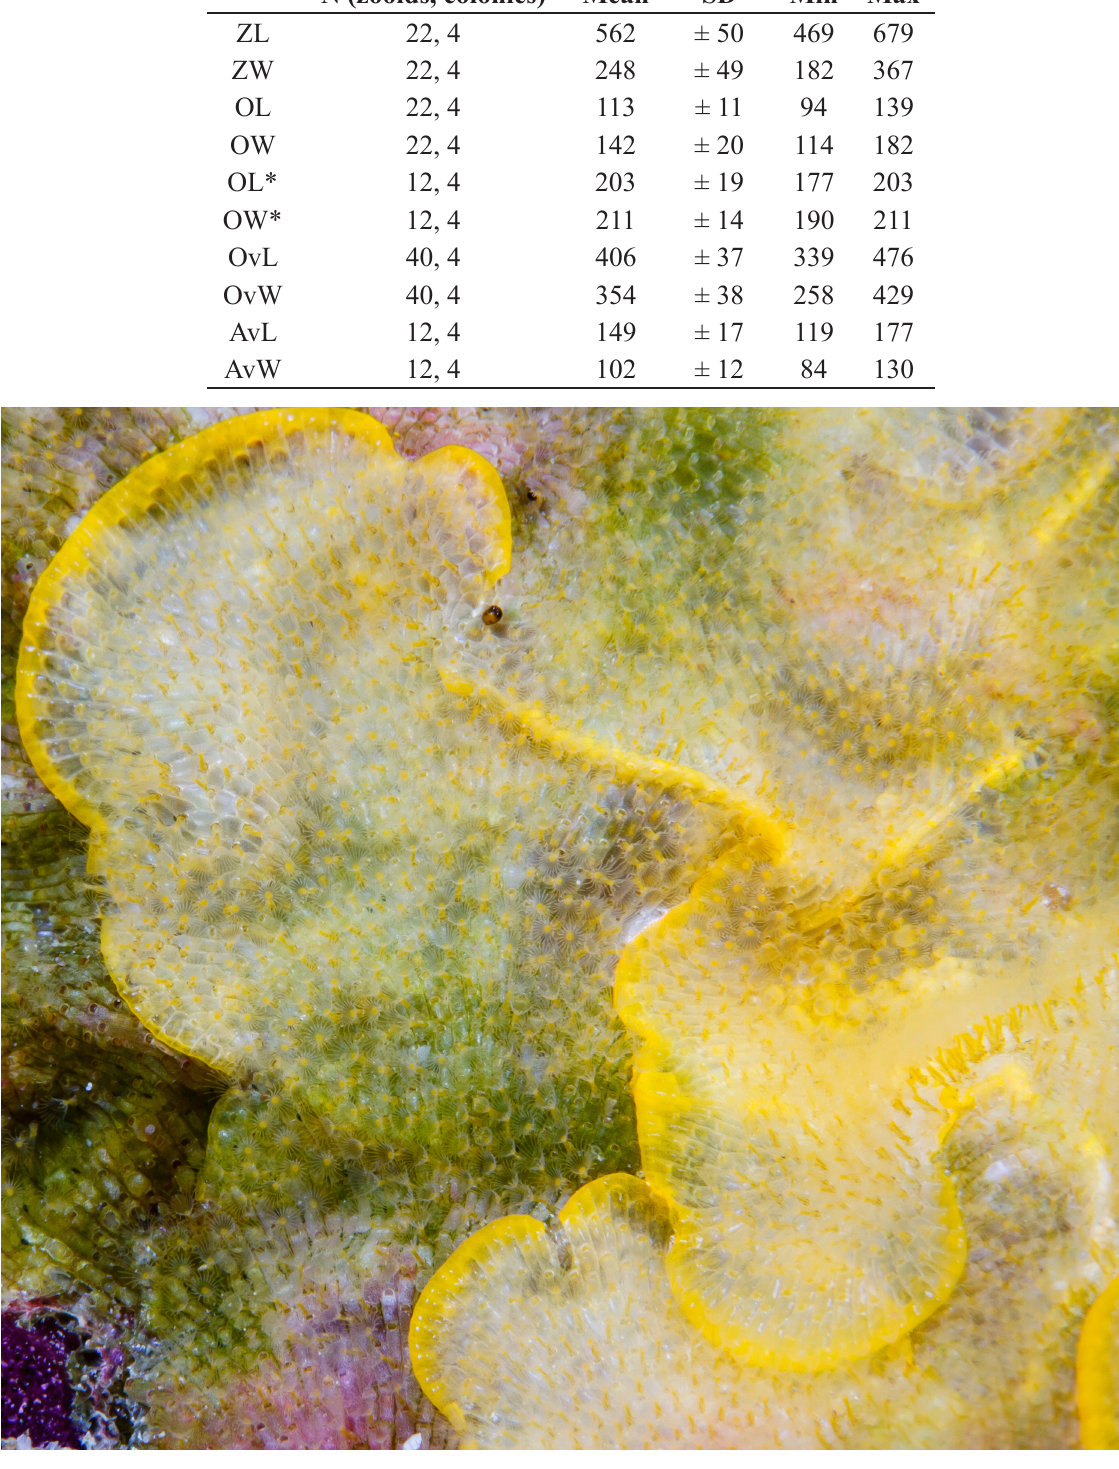
Fig. 7. Powellitheca terranovae gen. et sp. nov. Underwater photograph taken by Dr. Vincent Zintzen (Department of Conservation, NZ) at the Poor Knights Islands, off the NE coast of North Island, north of Auckland, New Zealand. Note the band of yellow pigment at the colony’s growing edges and the 19 yellow tentacles of the